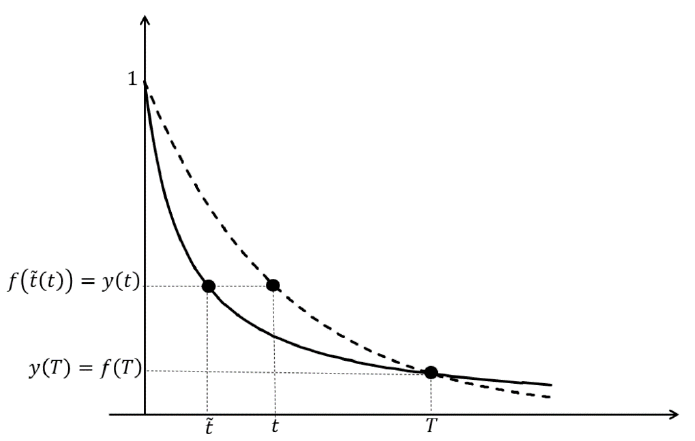
Figure 2. Correspondence between the function 𝑡̃(𝑡) and the time scanned by exponential discounting.